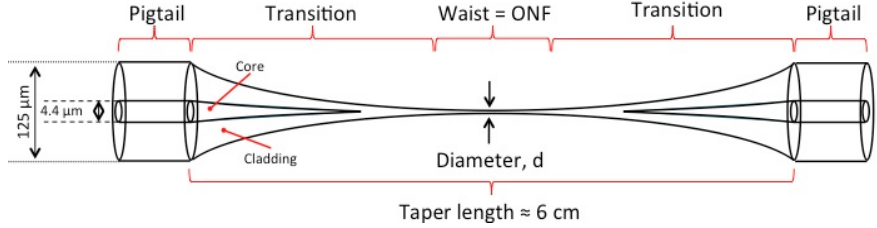
Figure 1. Schematic illustration of an optical nanofiber with a 125 μm outer diameter and a core diameter of 4.4 μm. The narrowest region has a diameter in the range of hundreds of nanometers. Typical taper lengths are ~6 cm, with the waist region being a few mm in